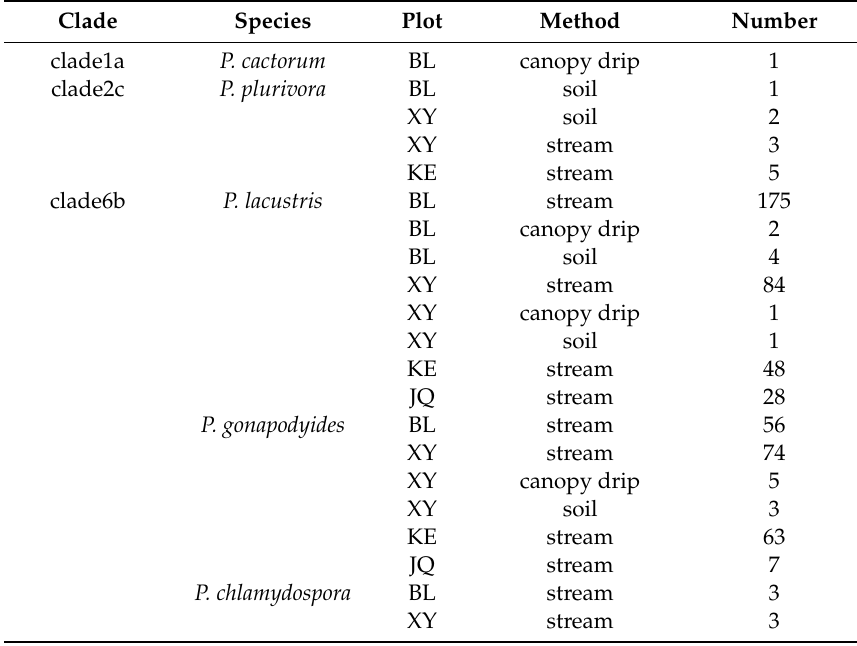
Table 1. The information of 621 Phytophthora strains relating to clades, species, methods, numbers, and plots including Xin Yuan (XY), Ba Lian (BL), Ku Erdening (KE), and Jin Qikesai